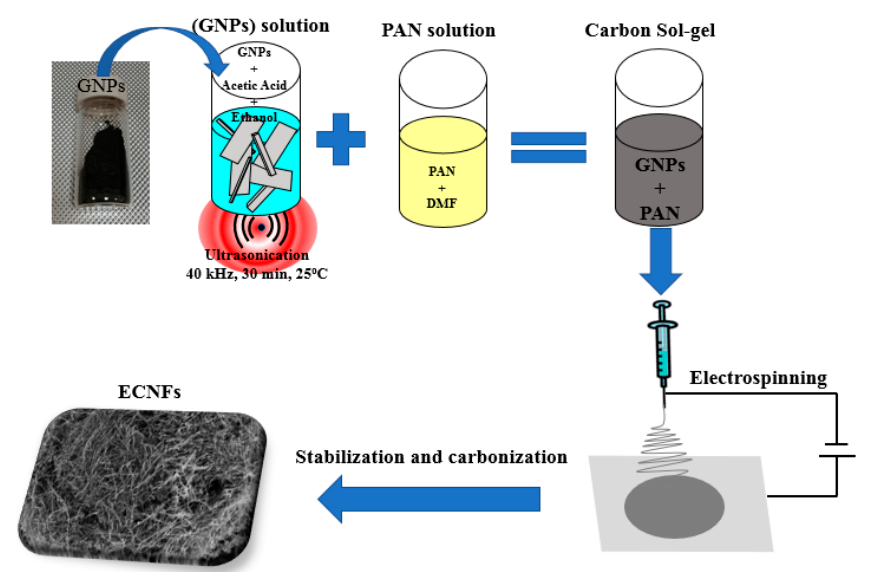
Figure 1. Schematic of CNF synthesis.